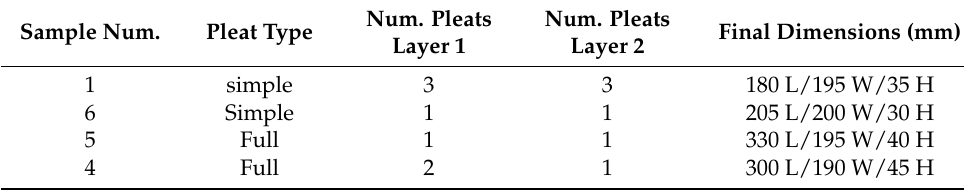
Table 1. Pleating types–second experimental campaign: samples’ data. Sample Num.